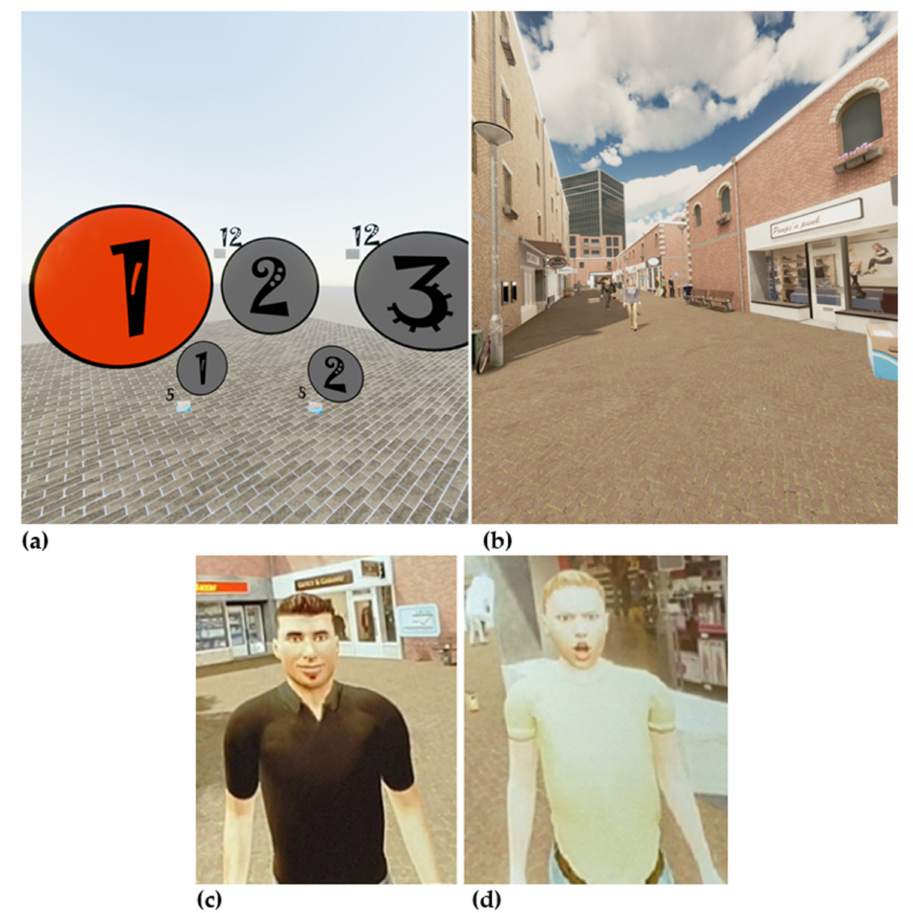
Figure 1. Virtual Reality Game for Aggression Impulsive Management (VR-GAIME), home screen ( a ), virtual shopping street ( b ), agreeable avatar ( c ), and disagreeable avatar ( d